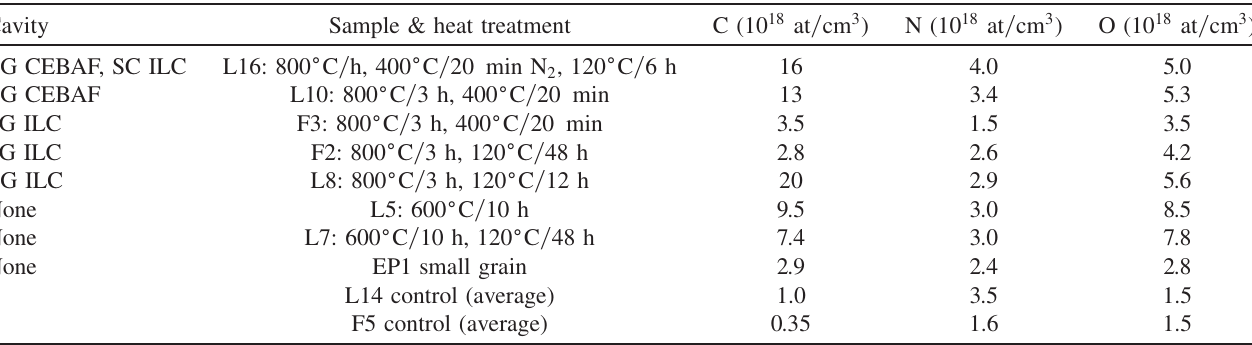
TABLE VI. SIMS Measurements of C, N, and O, all at Cs þ 14.5 keV. Cavity Sample & heat treatment